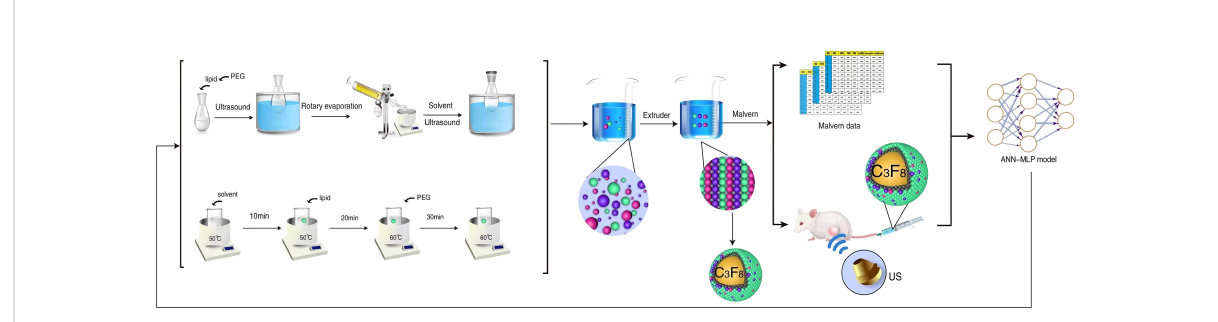
FIGURE 1 Schematic diagram showing the process of ultrasound contrast agent synthesis and neural network model